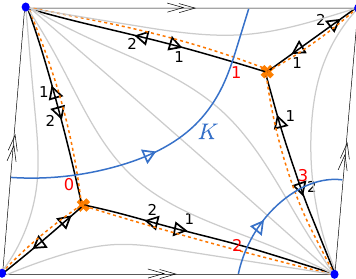
Figure 39 . WKB foliation on a torus with one puncture (blue dot). We also show the standard projection of a loop K , whose x 3 -pro(cid:12)le is speci(cid:12)ed by the red numbers, following the convention we introduced in (cid:12)gure 38.